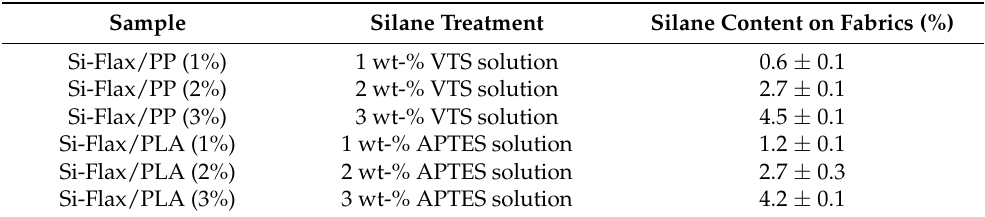
Table 1. Details of Flax/PP and Flax/PLA fabrics treated with different concentrations of each silane